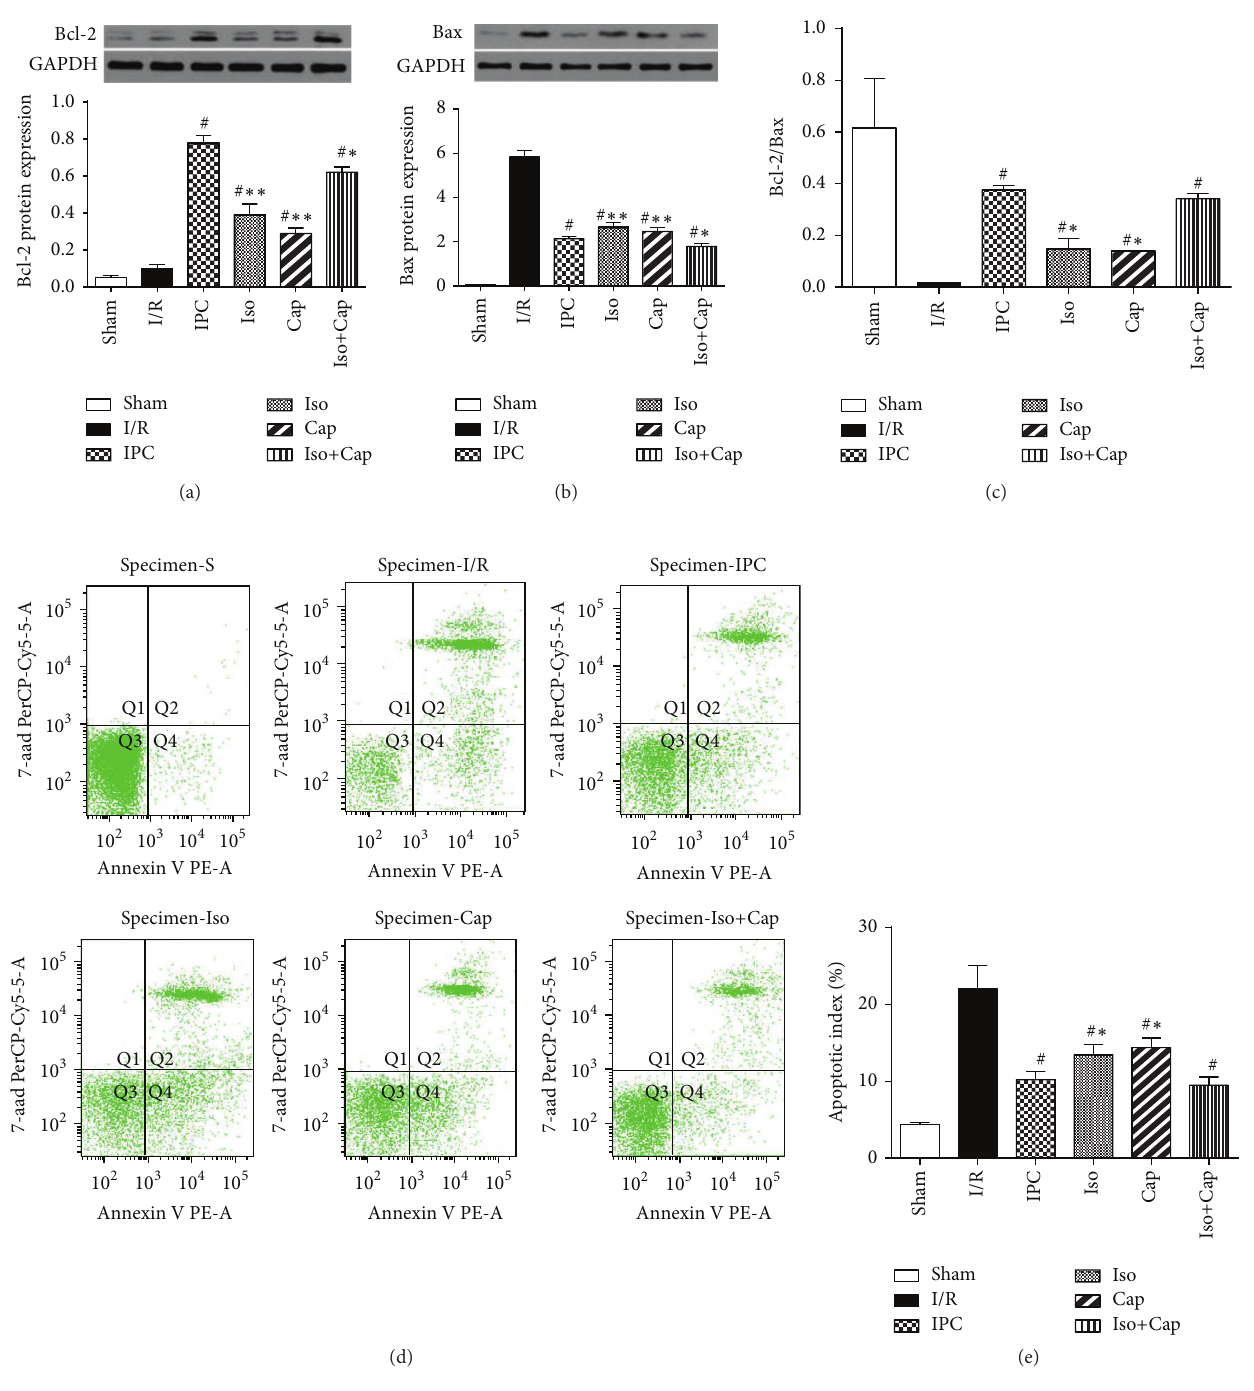
Figure 5: Isoflurane (Iso) and captopril (Cap) attenuated postischemic myocardial apoptosis in rabbits. (a) Protein expression of cardiac Bcl-2, (b) protein expression of cardiac Bax, (c) ratio of Bcl-2 to Bax, (d) representative graphs showing the proportion of apoptotic myocytes,and(e)quantitationofapoptoticmyocytes.Sham:shamoperatedcontrol;I/R:rabbitssubjectedtomyocardialischemiareperfusion (MI/R); Cap: rabbits treated with captopril (25 mg/kg given intravenously 24 h) prior to inducing MI/R; Iso: rabbits received isoflurane preconditioning (15min 1.1% end tidal isoflurane followed by a 15min washout period before inducing MI/R); Iso+Cap: rabbits received captopril in combination with Iso. Data are shown as means ± SD, with 𝑛 = 8 animals per group. # 𝑃 < 0.05 versus I/R, ∗ 𝑃 < 0.05 versus